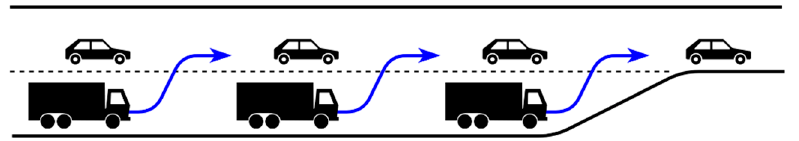
Figure 3. A lane merge on a highway with the cooperative cars creating gaps for the trucks to form a zip-like pattern.